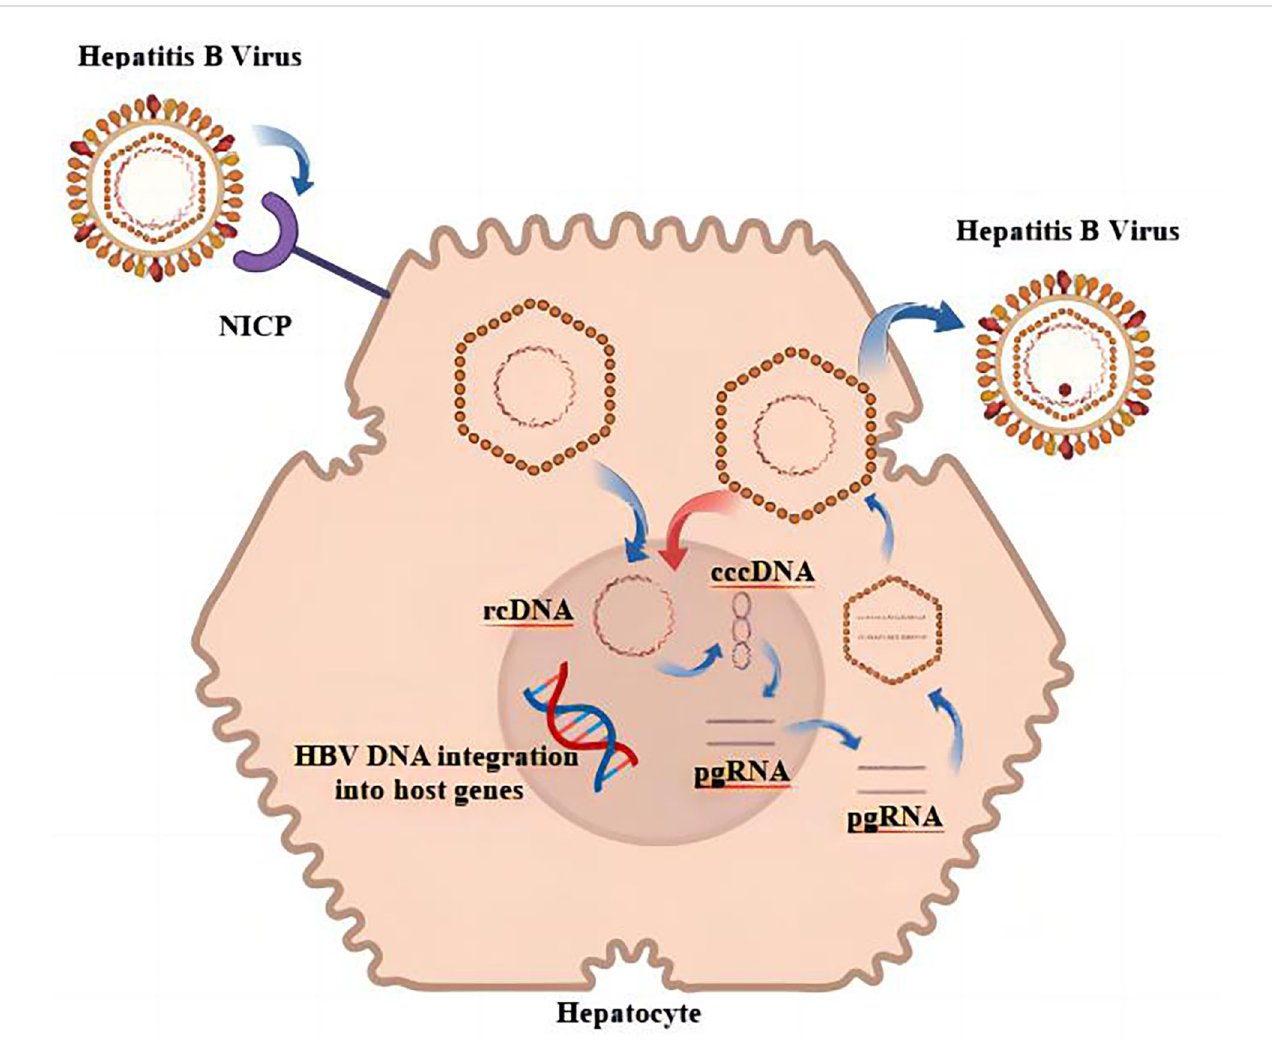
FIGURE 1 Replication cycle of